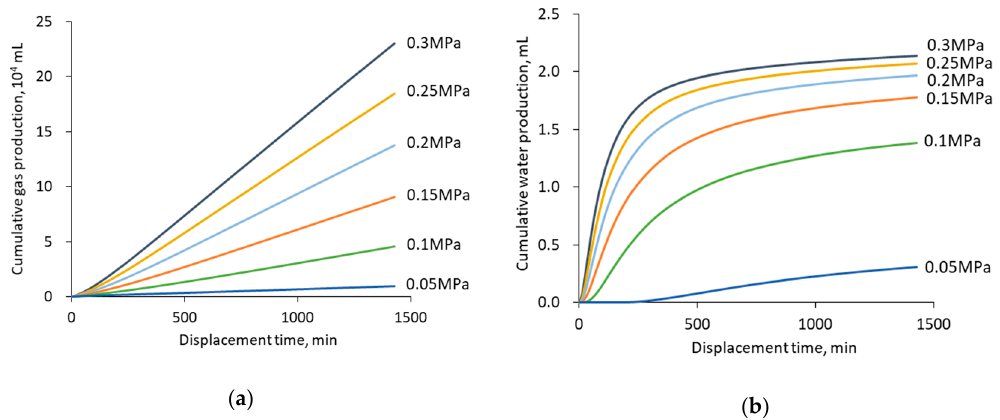
Figure 7. Simulated cumulative gas ( a ) and water ( b ) production volumes with varying pressure drops.